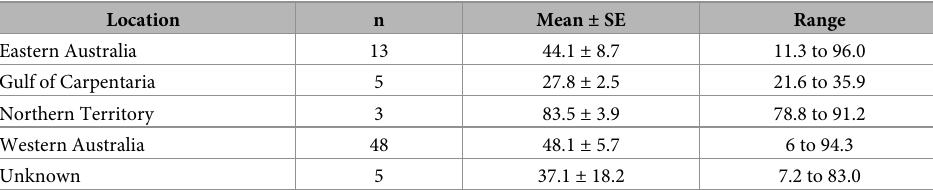
Table 1. Flatback sample details.